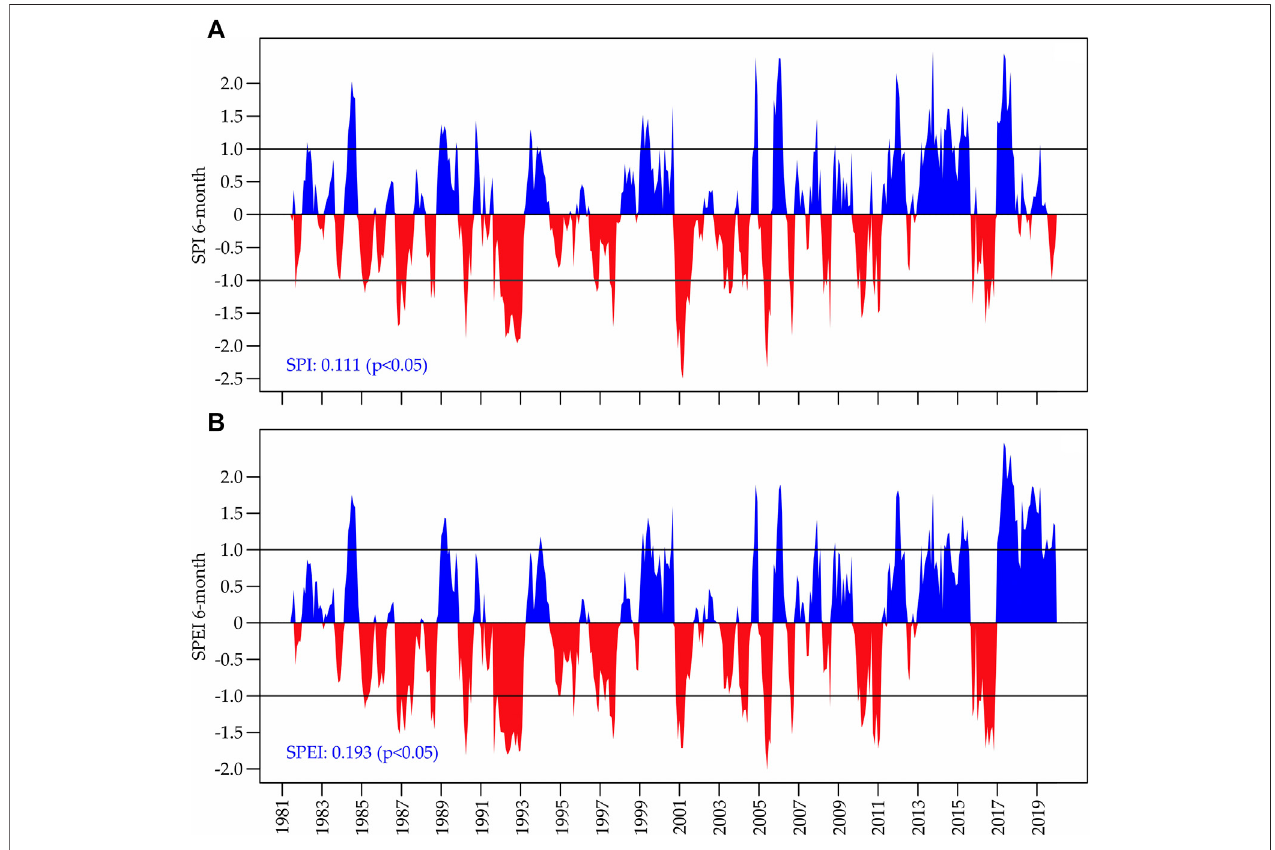
FIGURE 5 | SPI 6-months (A) and SPEI 6-months (B) for the 1981 – 2019 period with wet, normal and drought bands. The amount of change (including the statistical signi fi cance) for each index is shown at the left bottom of each subgraphic.